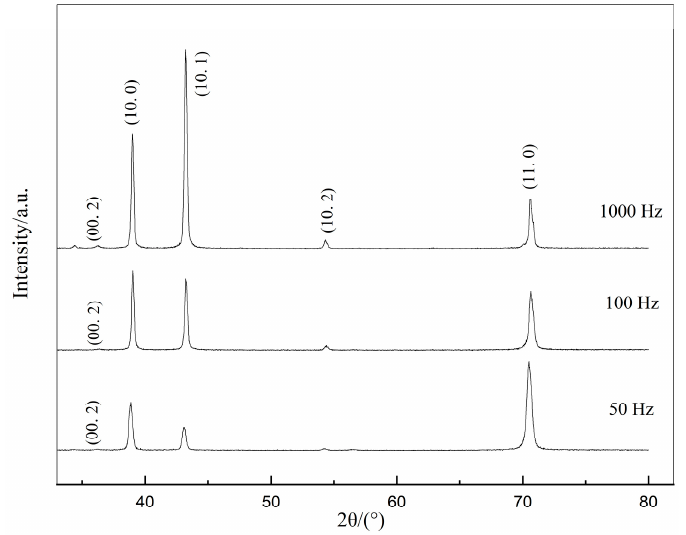
Figure 3. XRD patterns of electrodeposited zinc under 50 Hz, 100 Hz, and 1000 Hz pulse fre- quency.